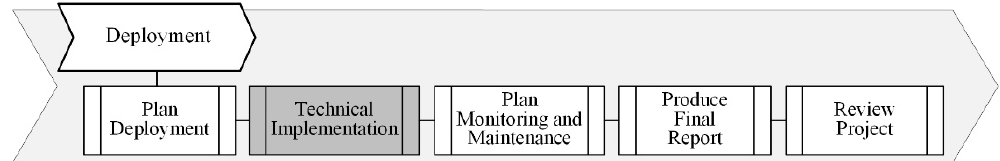
Figure 4. The “Technical Implementation” task as part of the “Deployment” phase.